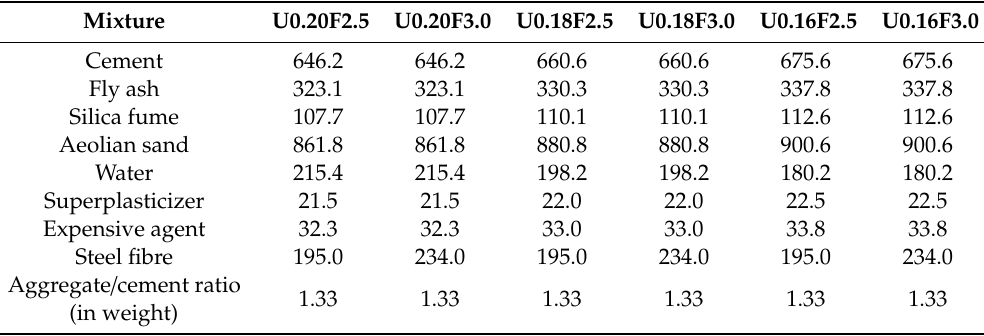
Table 2. Mixtures of ultra-high-performance concrete (UHPC) (kg/m 3 ).